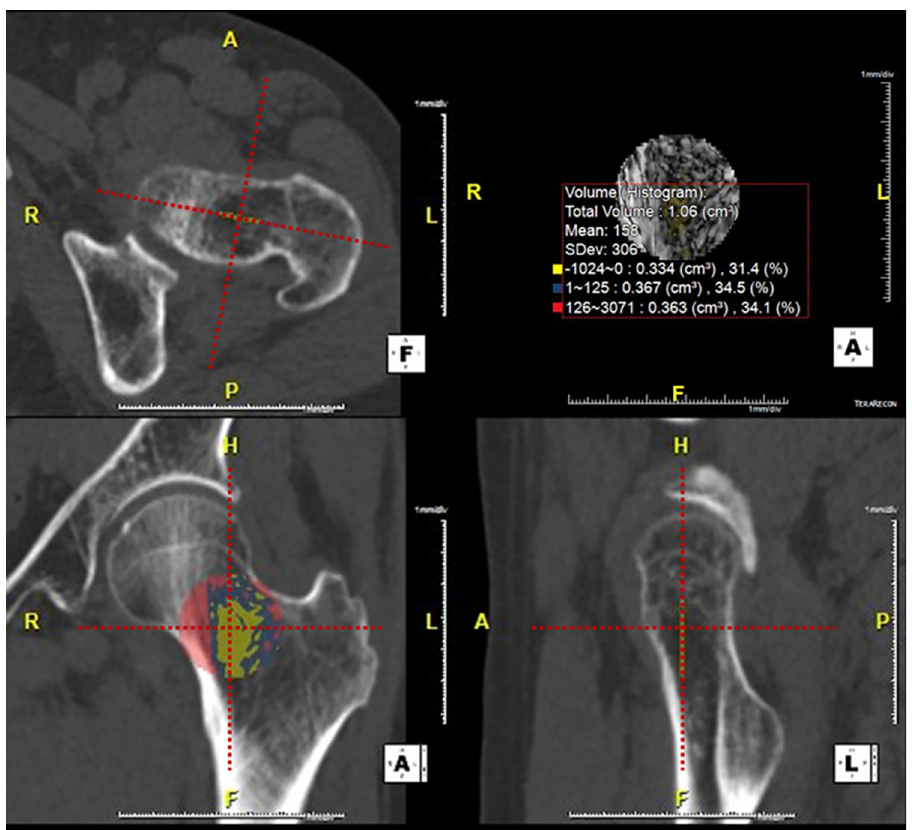
Fig 3. 2D coronal -ROI measurement. 2D coronal -ROI is drawn on the true coronal reformatted image under the three- dimensional central point guidance in the femoral neck. The largest circular ROI is drawn around the 3D central point adjacent to the outer cortical bone. Total volume, mean-HU, and HU histogram analysis (HUHA) are simultaneously calculated and displayed.